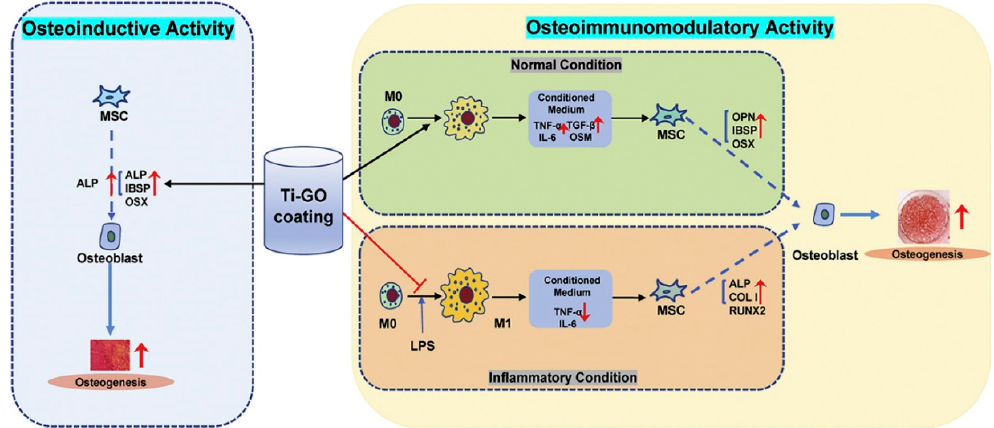
Figure 9. GO coatings on Ti substrate display significant biocompatibility. In osteogenic activity, GO coatings enhance osteogenic genes, osteoinductive ability and extracellular matrix mineralization of the MSCs, while GO normalizes polarization through receptors which stimulate cytokines and thus improve osteogenic differentiation [154].